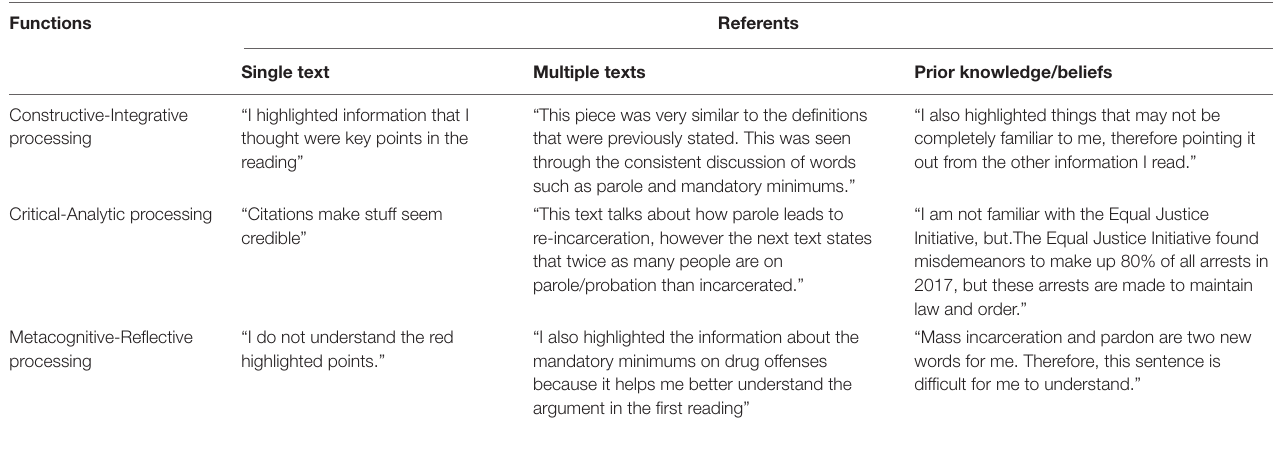
TABLE 2 | Examples of strategy explanation